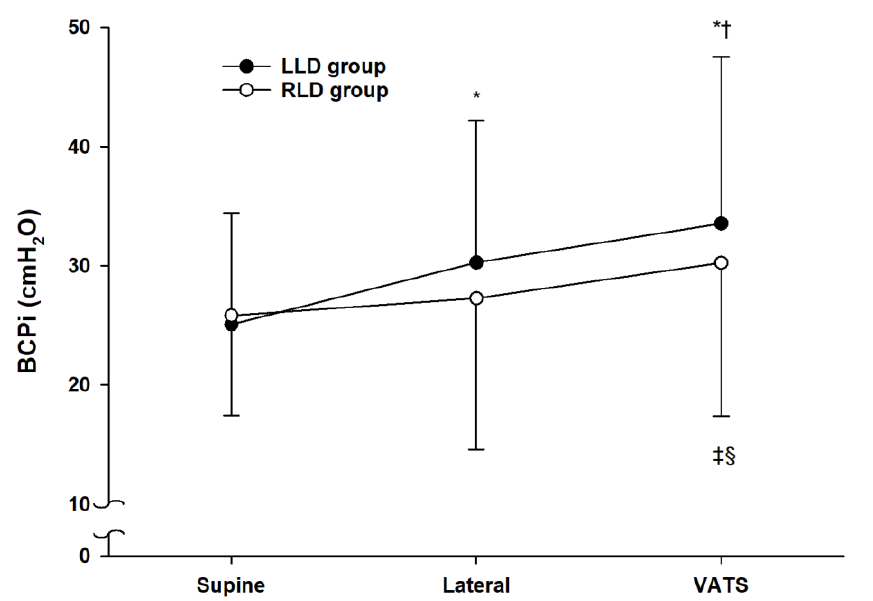
Figure 1. The changes of BCPi at supine position, after lateral positioning and after starting the VATS operation. The black circles show the mean BCPi values with standard deviation of the patients in the LLD group. The white circles show the mean BCPi values with standard deviation of the patients in the RLD group. * p < 0.001 compared to supine position, † p = 0.001 compared to lateral position, ‡ p < 0.05 compared to supine position, § p < 0.05 compared to lateral position. BCPi, initial established bronchial cuff pressure; VATS, video-assisted thoracoscopic surgery; LLD, left lateral decubitus; RLD, right lateral decubitus.